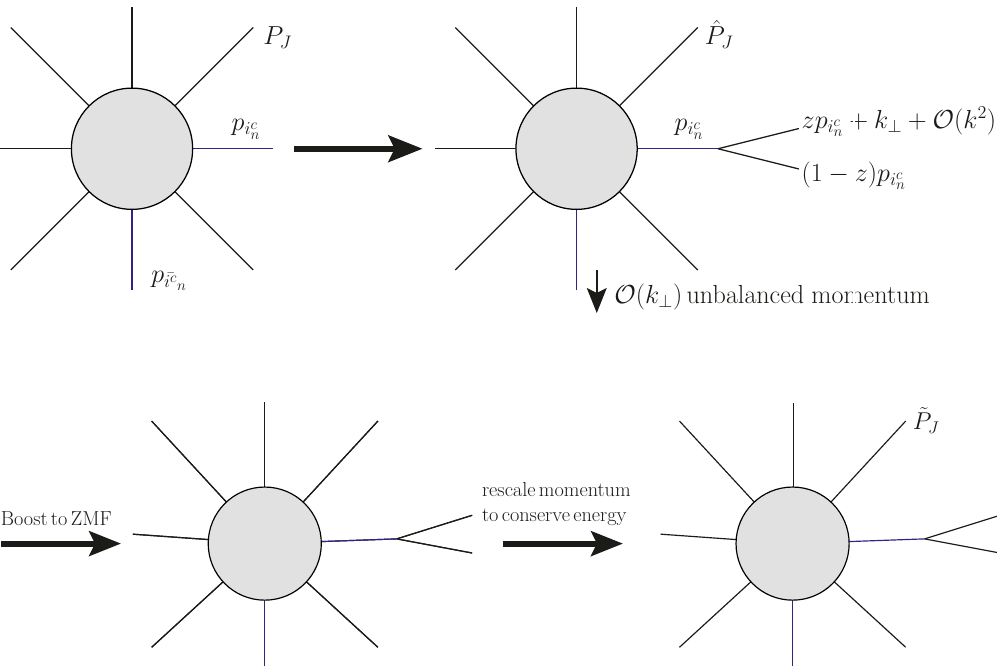
Figure 3 . A summary of the dipole shower global recoil scheme (a scheme for energy-momentum conservation). In words: a new particle is emitted which leaves some momentum unbalanced (in the direction of the colour connected parton and in the plane transverse to the dipole); perform a Lorentz boost to the new ZMF, and re-scale the jet momenta in such a way that the rescaling does not change the k ? of the emission. This leaves an n -parton ensemble with the same total energy and total momentum as the n 1-parton (cid:0)